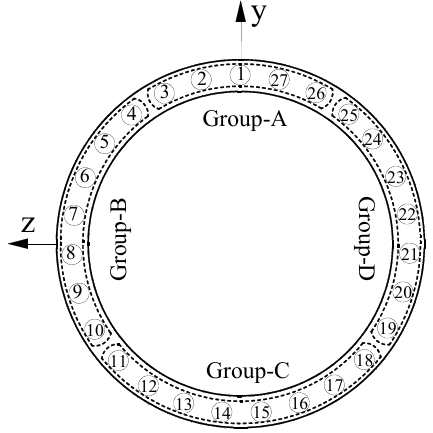
Figure 4. Distribution of thrust cylinders in each group.